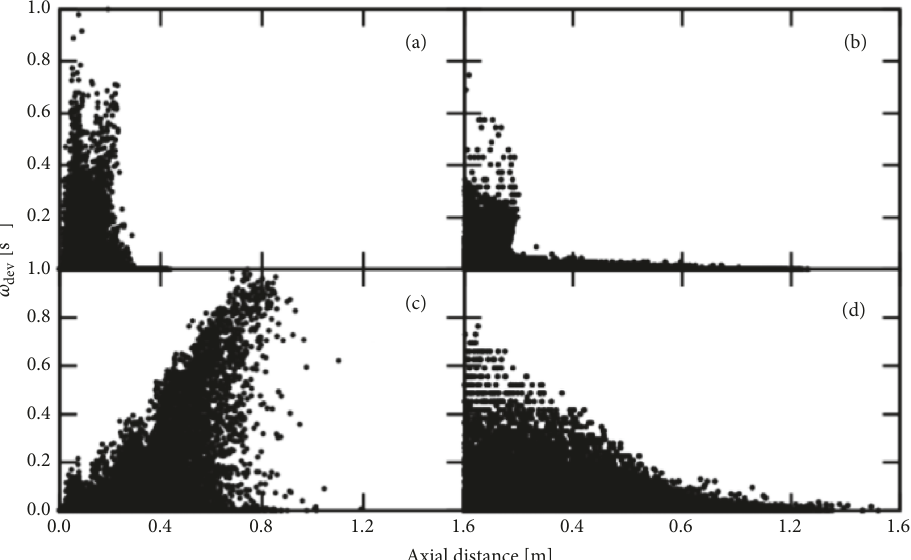
Figure 7: Devolatilization rate along the axial direction of the furnace: (a) SC coal, (b) DC coal, (c) SC biomass, and (d) DC biomass. Rates normalised by maximum rate obtained with SFOM of corresponding fuel. Particle ensemble collected after 6 seconds of physical